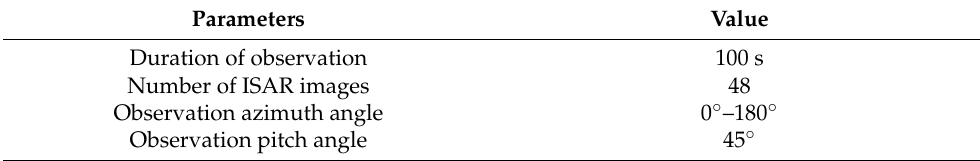
Figure 5. Simple point model of the SRST and corresponding ISAR image sequence: ( a ) Simple point model of the SRST, ( b ), ( c ), and ( d ) the 1st, 13th, and 24th frames, respectively. Table 1. Radar observation